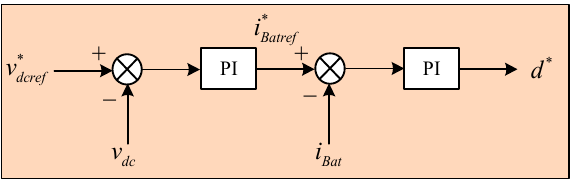
Figure 5. Control diagram of the DC-DC converter.